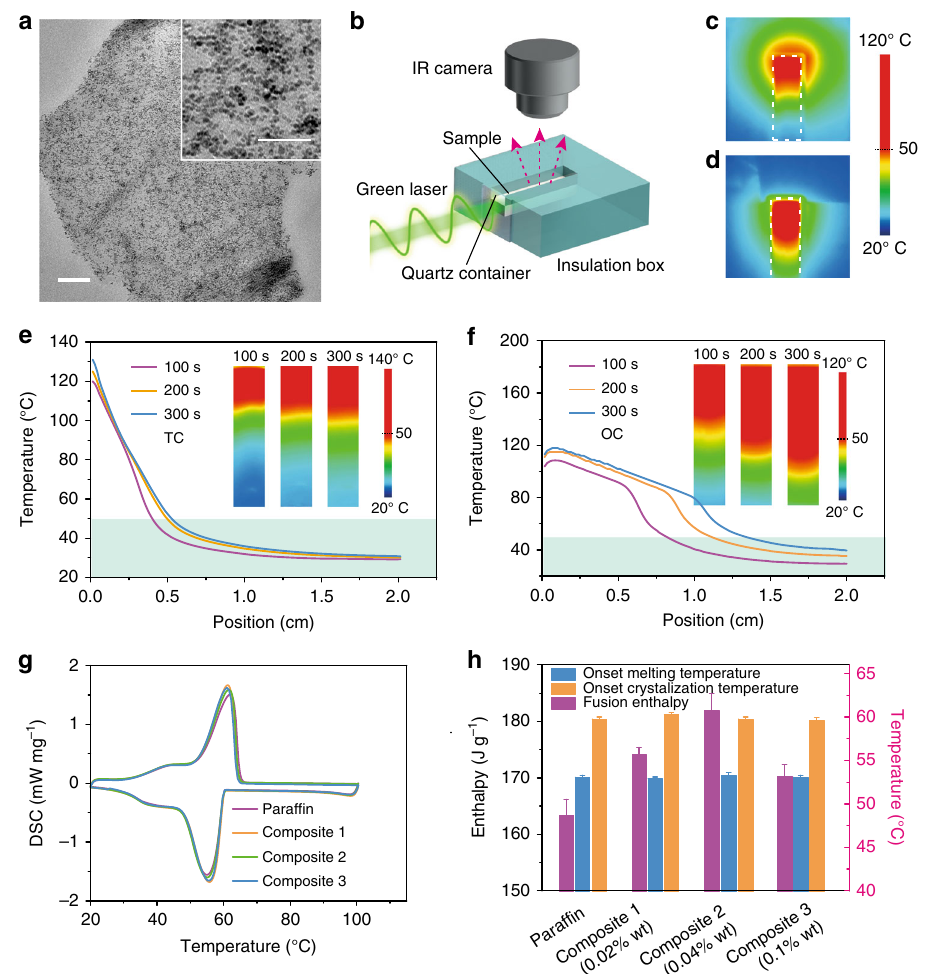
Fig. 2 Charging of paraf fi n composites fi lled with Fe 3 O 4 @graphene nanoparticles. a Transmission electron microscopy (TEM) image of hybrid Fe 3 O 4 @graphene optical absorbers. The scale bar is 200 nm. The inset TEM image at a higher magni fi cation shows the dense decoration of Fe 3 O 4 nanoparticles on the surface of graphene sheets. The scale bar of the inset TEM image is 50 nm. b Schematic of experimental setup for charging of paraf fi n composites. A green laser (532 nm) with a power density of 4 W cm − 2 is used to illuminate a black aluminum foil in thermal charging (TC) mode or directly illuminate the surface of composites of paraf fi n-Fe 3 O 4 @graphene (0.02 wt%) in optical charging (OC) mode. c , d Infrared (IR) image of a thermally and optically charged sample after illumination for 100 s. The dashed line marks the boundary of the sample within the cuvette. e , f Time-sequential temperature distribution pro fi les of thermally charged sample and optically charged sample. The temperature pro fi les were extracted from the central line of the IR images. g Differential scanning calorimetry (DSC) curves of paraf fi n and paraf fi n composites with different loading of Fe 3 O 4 @graphene nanoparticles (composite 1: 0.02 wt%, composite 2: 0.04 wt%, composite 3: 0.1 wt%). h Comparison of fusion phase-change enthalpy, melting, and solidi fi cation temperatures of neat paraf fi n and paraf fi n-Fe 3 O 4 @graphene